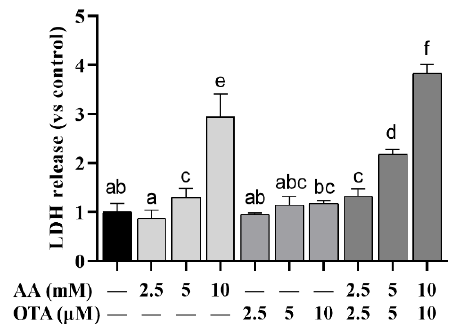
Figure 2. Effect of AA and OTA on LDH release. a – f Different letters indicate significant differences, p < 0.05.